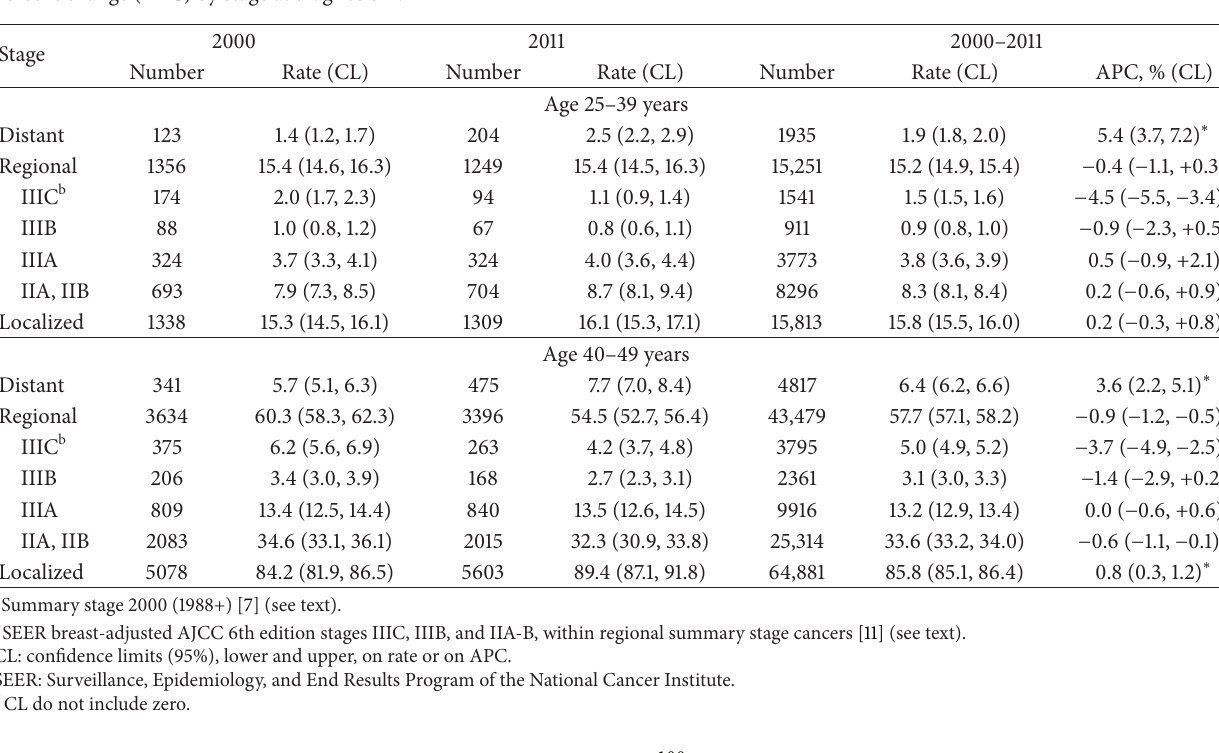
Table 1: Age-standardized incidence rate for women aged 25–39 years and 40–49 years with invasive breast cancer in SEER registries: annual percent change (APC) by stage at diagnosis a,b .